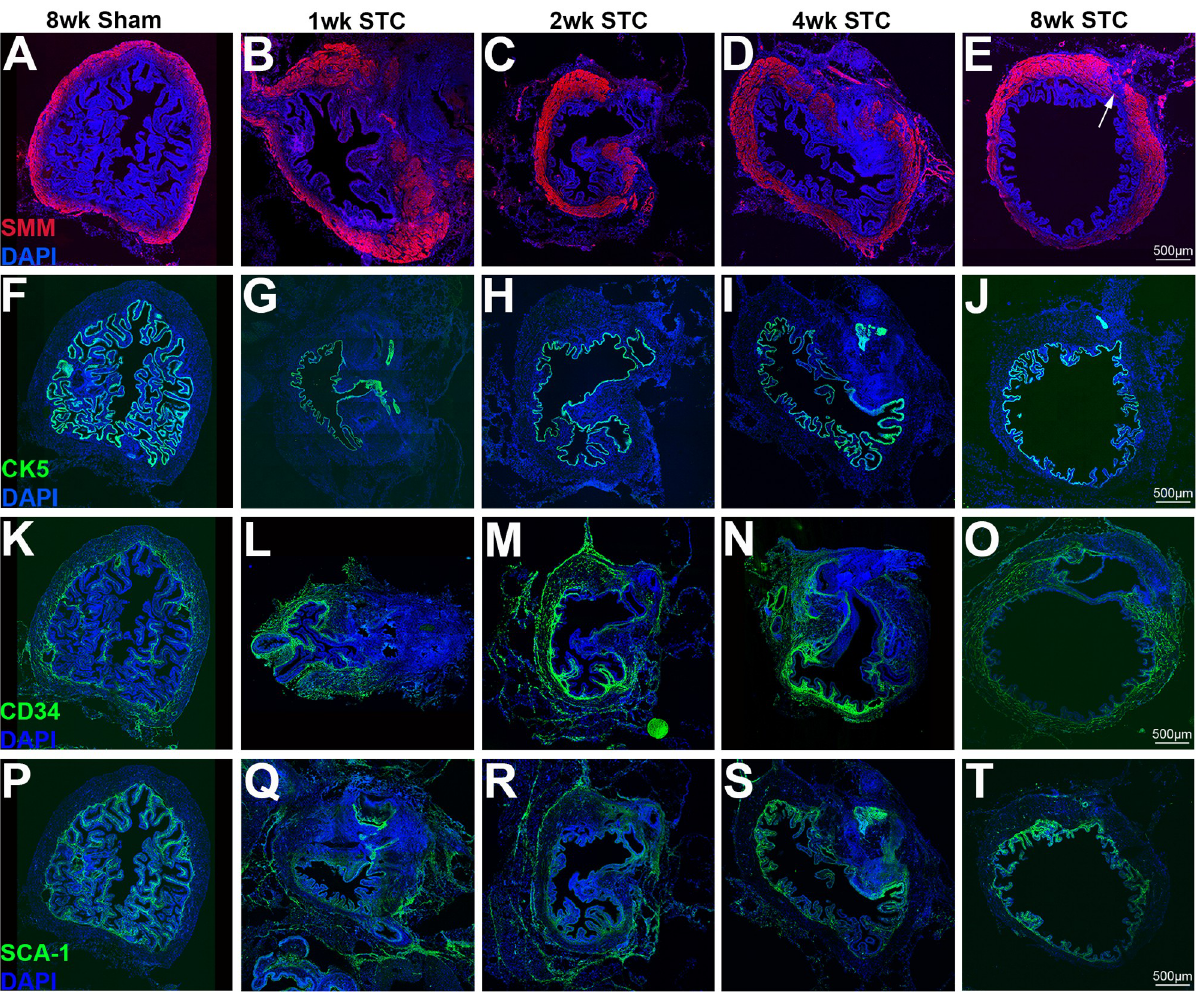
Fig 5. Regrowth of the detrusor muscle 8wk after STC surgery. Tiled confocal images of sham operated and STC operated bladders 1wk (7d PS), 2wk (14d PS), 4wk (28d PS) and 8wk (56d PS) after surgery. (A-E) The top row of panels shows staining for smooth muscle myosin (SMM) in red with nuclei counterstained in blue (DAPI). (F-J) Row of panels shows staining for cytokeratin-5 (CK5) marking the urothelium (green). (K-O) Row of panels shows staining for CD34 marking BMSCs (green). (P-T) Row of panels shows staining for Sca-1 marking BMSCs (green). Magnification bars are 500 μ m and are shown in the lower portion of panels (E, J, O, T). Arrow in (E) points to gap in smooth muscle regrowth at